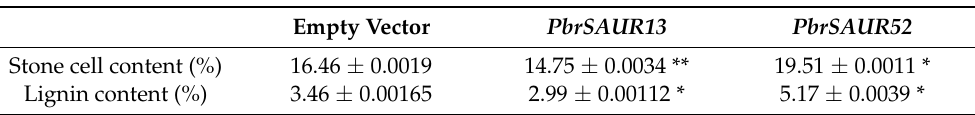
Table 1. The contents of stone cells and lignin in pear fruit overexpressed by PbrSAUR13 and PbrSAUR52.